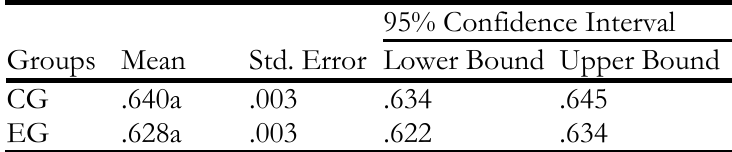
Table 5. Estimated Marginal Means of Accuracy Scores in the Two Groups